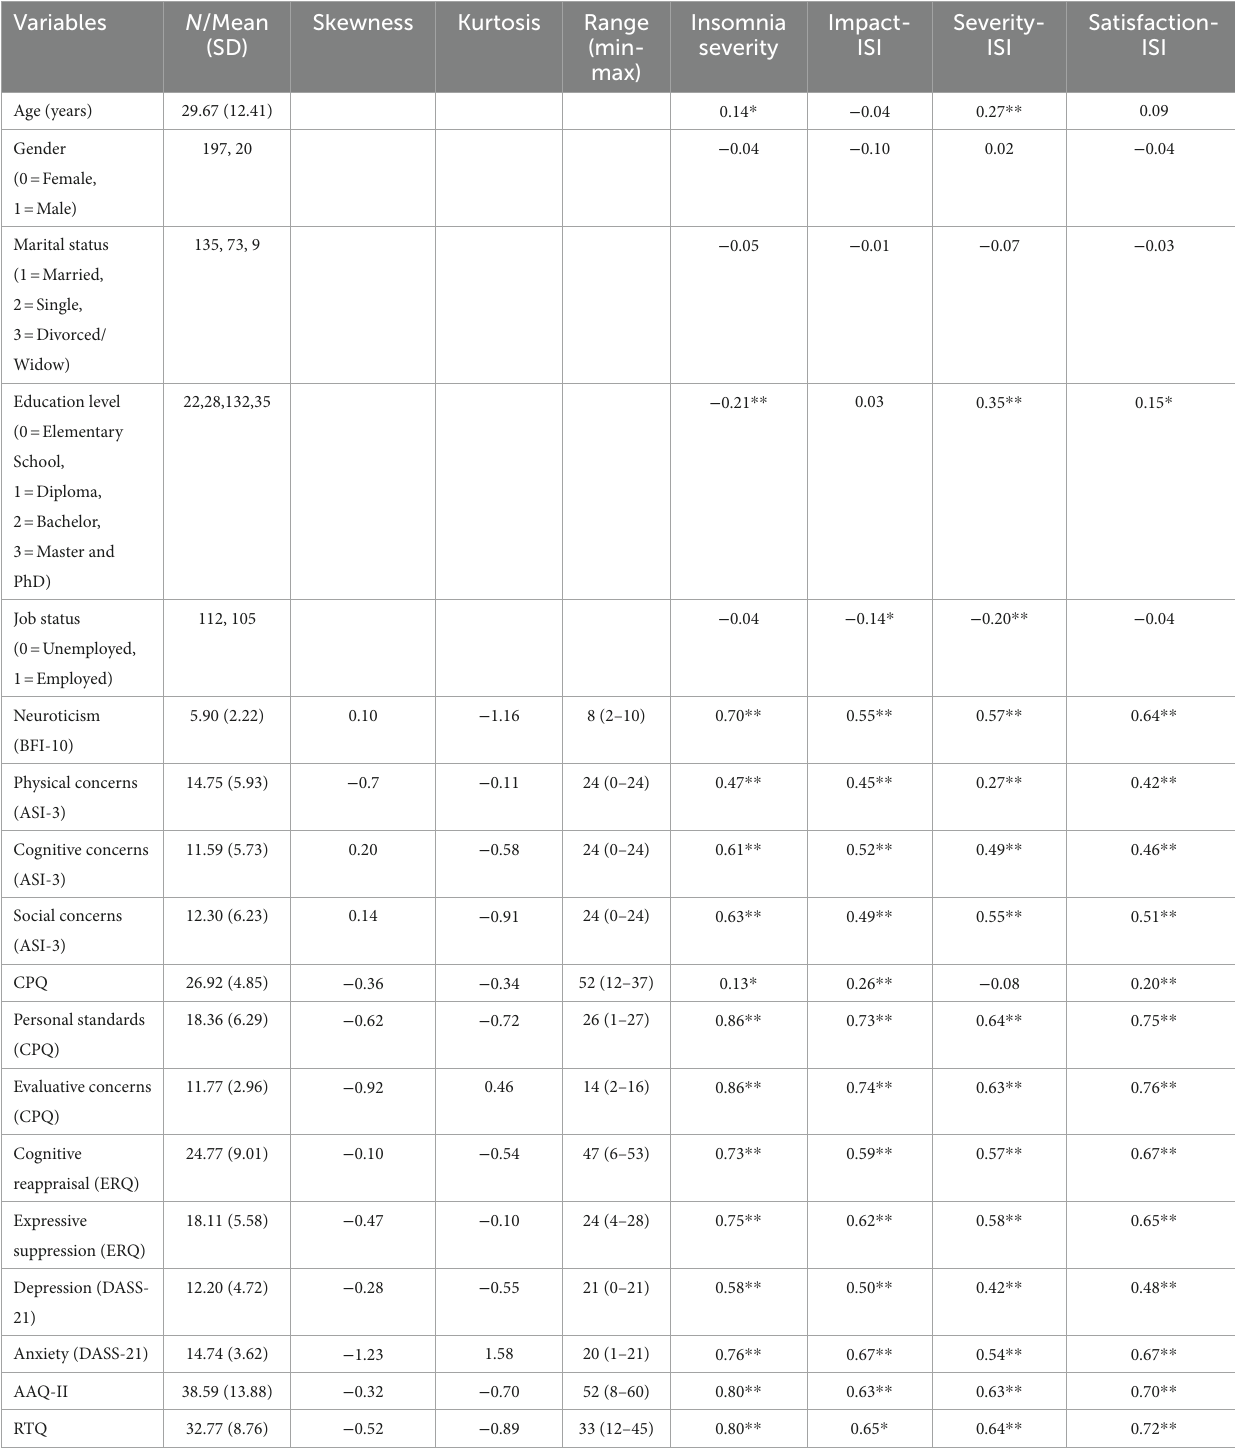
TABLE 1 Descriptive statistics and correlations of insomnia severity with demographics characteristics, and transdiagnostic vulnerability factors in insomnia.